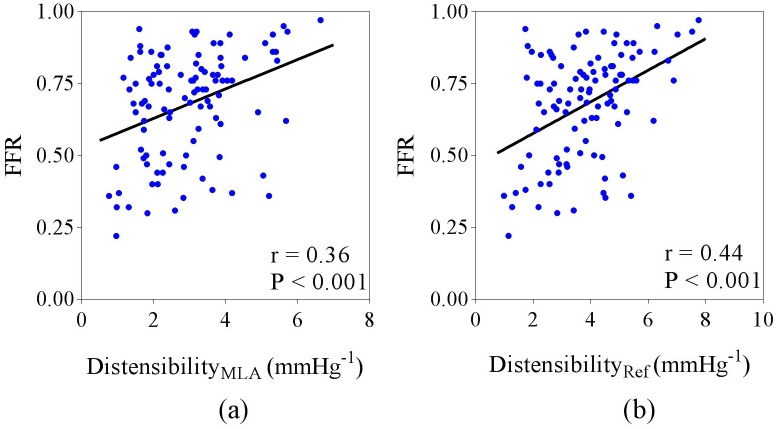
Scatterplots showing relationship between FFR and distensibility.(a) DistensibilityMLA and (b) DistensibilityRef.